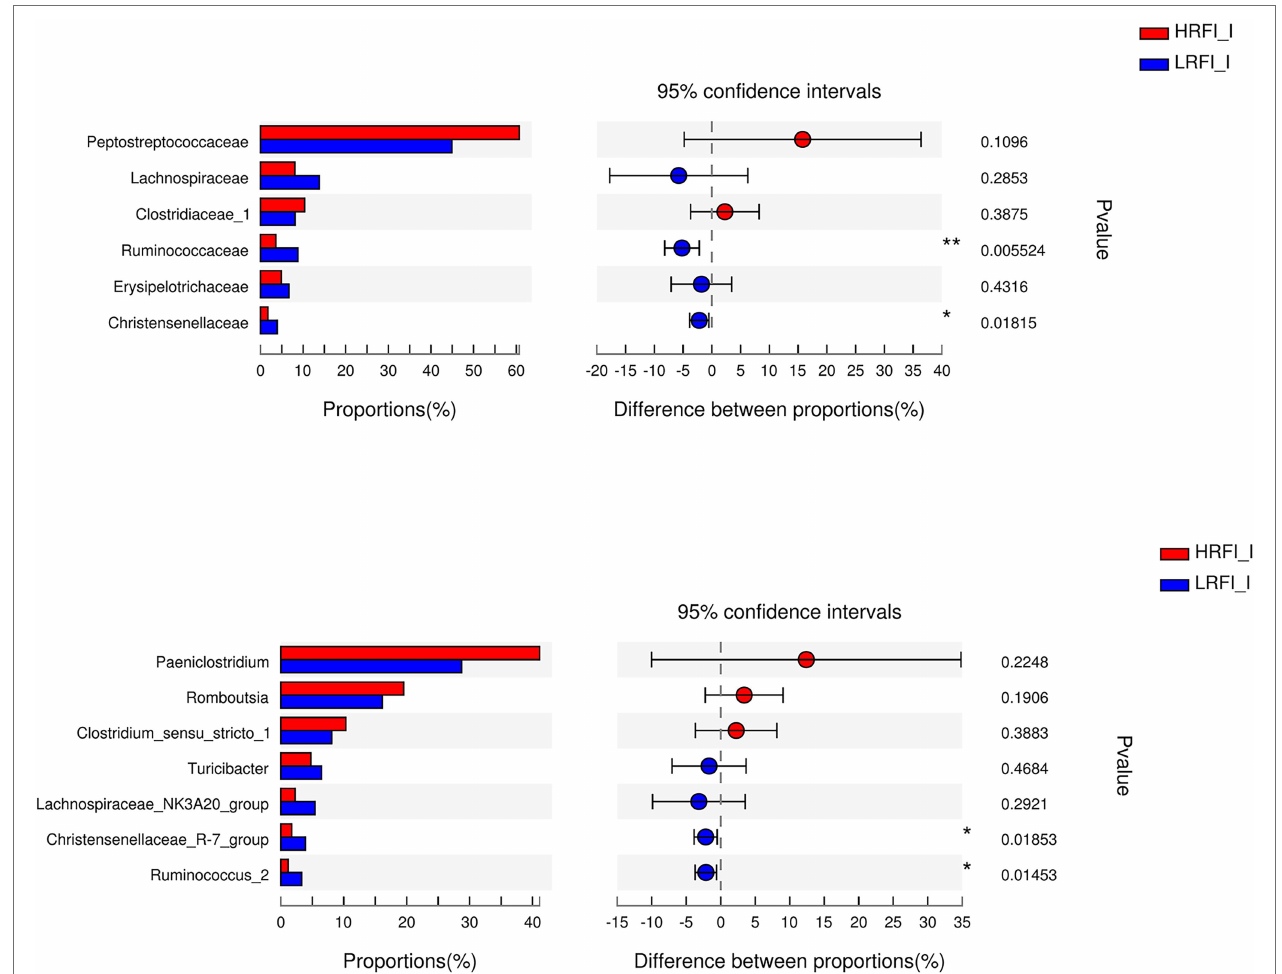
FIGURE 7 | Significantly differential abundant families, and genera (relative abundance >1%) with the ileum bacteria. Positive and negative differences indicate a greater abundance in the HRFI group and LRFI group, respectively. *Represents 0.01 < p < 0.05 and ** represents 0.001 < p <